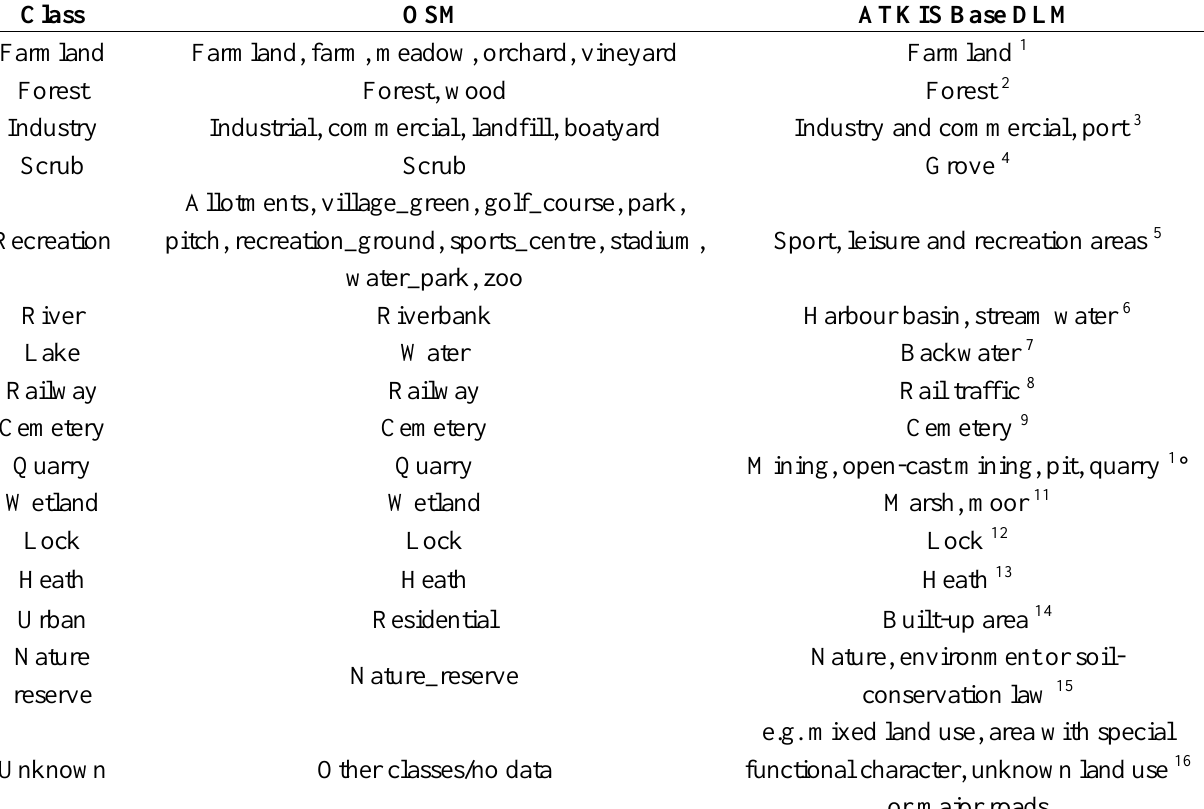
Table 1. A dictionary between OSM and ATKIS Base